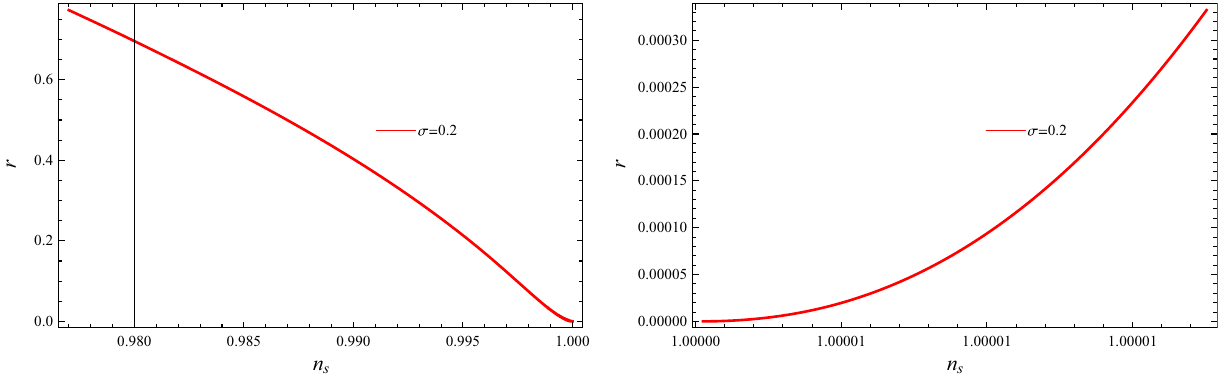
Fig. 16 Plot of r versus n s for GCCG model in weak (left panel) and strong (right panel) dissipative regimes for negative potential with n = 1